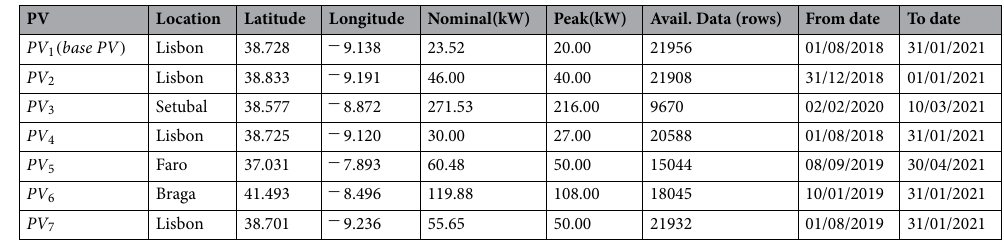
Table 1. Information of the PV plants that were used for the experimental application of the study.